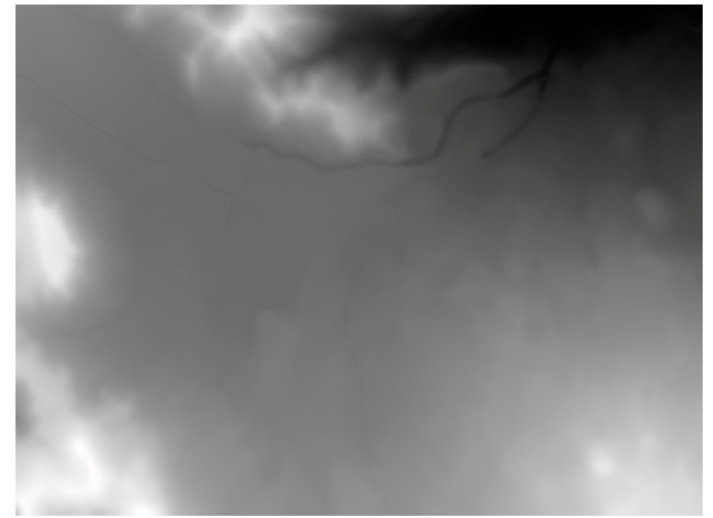
Figure 12. The modified DEM corresponding to a 1588 terrain height estimation.